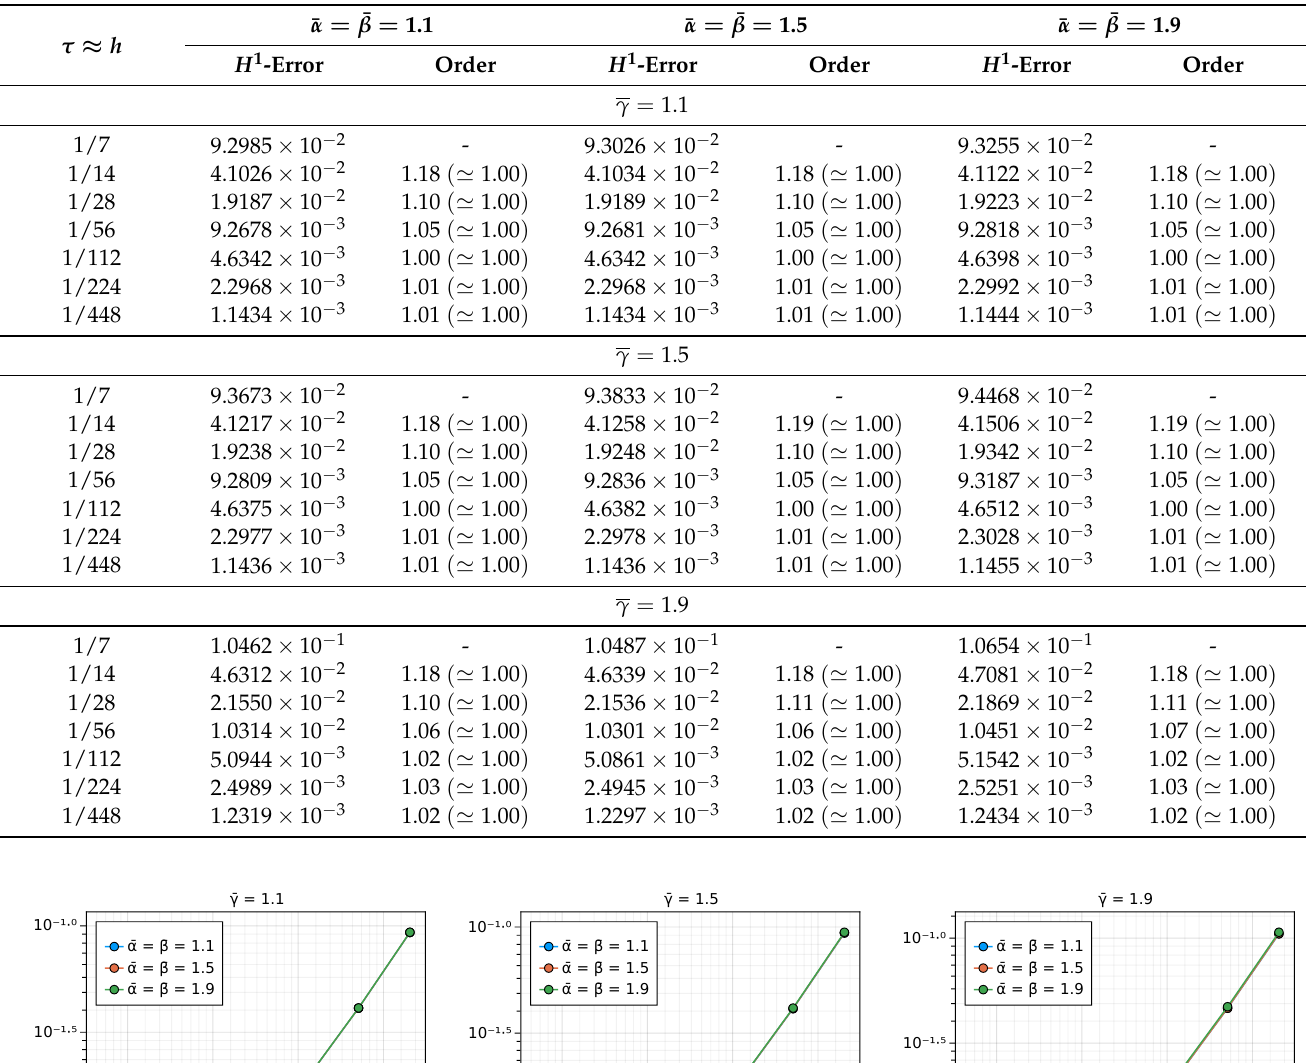
, i ≥ 2, calculated by i